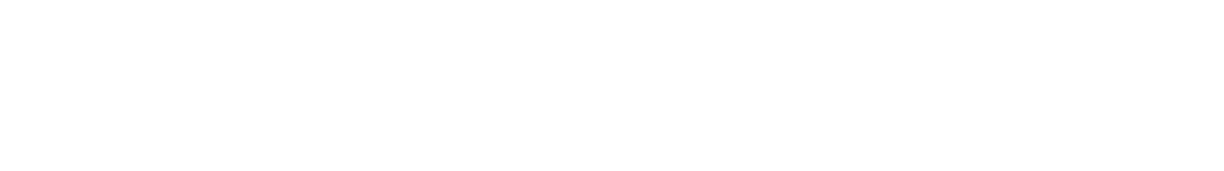
Frontiers in Materials |